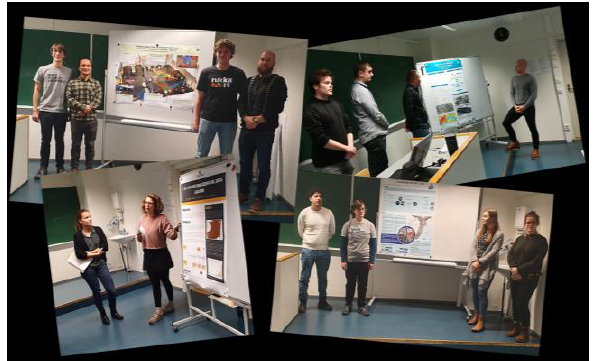
Figure 3. Examples of posters in a final